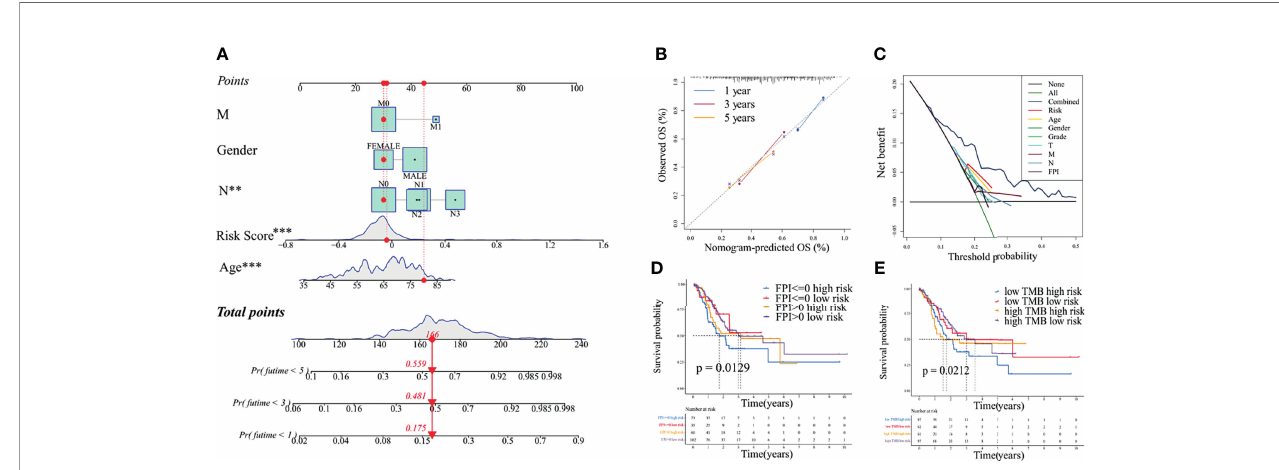
FIGURE 4 | Comprehensive analysis of excellent independent prognostic factors in The Cancer Genome Atlas — stomach adenocarcinoma cohort. (A) Nomogram constructed by independent prognostic factors with P < 0.05 in the multivariate Cox regression analysis. (B) Nomogram calibration curves for 1, 3, and 5 years. (C) Decision curves used to compare the accuracy of multiple models in predicting the survival of patients with gastric adenocarcinoma. “ Combined ” represents the model jointly constructed by all clinical characteristics in the fi gure. (D) Joint survival curves of the FPI and risk. (E) Joint survival curves of the TMB and risk. FPI, ferroptosis potential index; TMB, tumor mutation burden. ** P < 0.01; *** P <